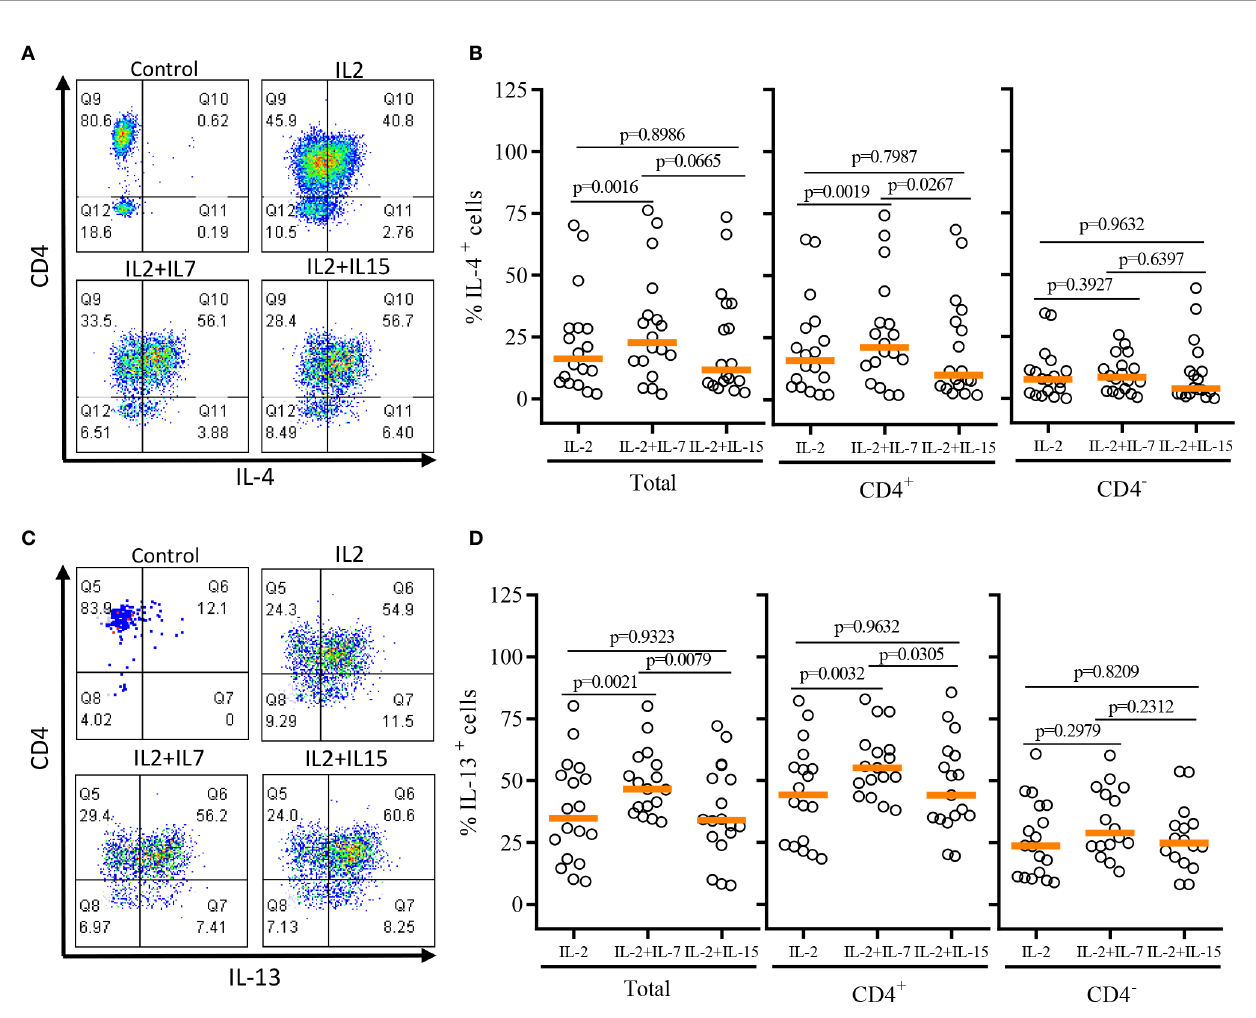
FIGURE 6 | Th-2 type cytokine production pro fi le of expanded human iNKT cells. The expanded iNKT cells were stimulated with PMA and Ionomycin, and intracellular cytokine production pro fi les were assessed through multi-color fl ow cytometry. (A) Representative fl ow cytometric analysis of CD4 and IL-4 expression of iNKT cells post-expansion. (B) Percent of IL-4 + total, CD4 + , and CD4 - iNKT cells in post-expansion with IL-2, IL-2+IL-7, and IL-2+IL-15. (C) Representative fl ow cytometric analysis of CD4 and IL-13 expression of iNKT cells in post-expansion. (D) Percent IL-13 + total, CD4 + and CD4 - iNKT cells in post-expansion with IL-2, IL- 2+IL-7, and IL-2+IL-15. Horizontal orange lines represent median values; p values are shown above group. Each symbol represents a value from a single